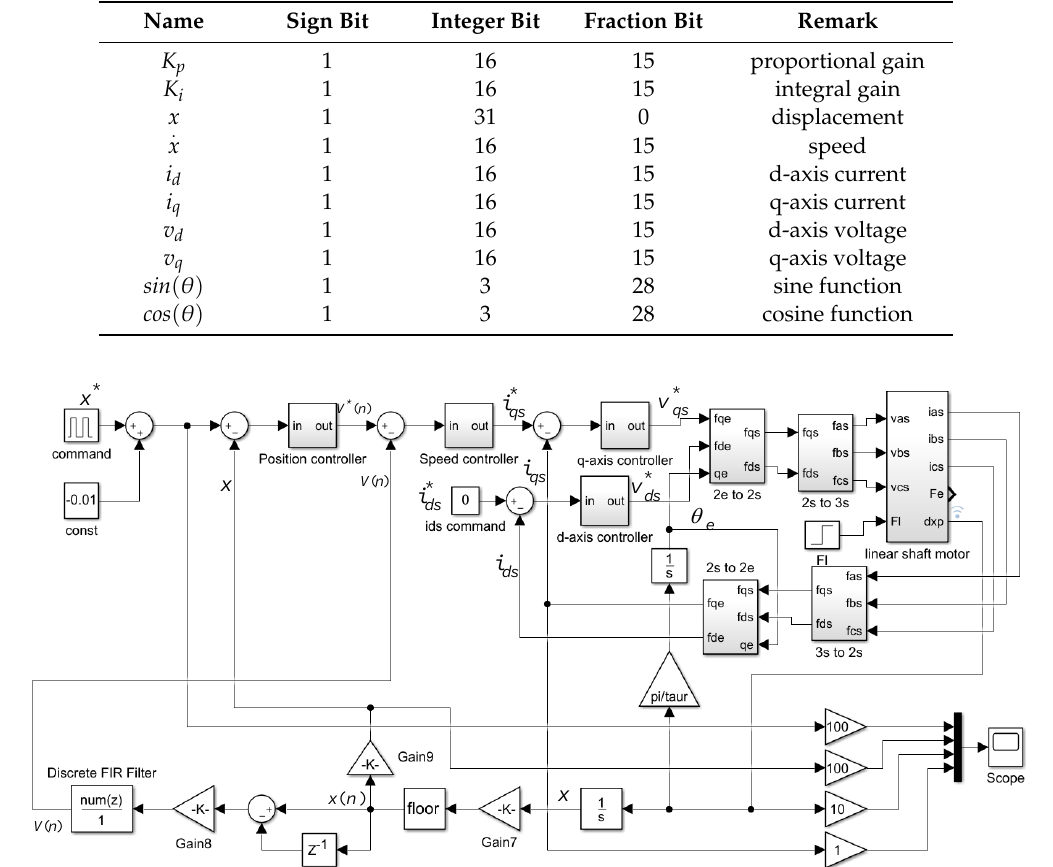
Figure 5. The block diagram of the simulation